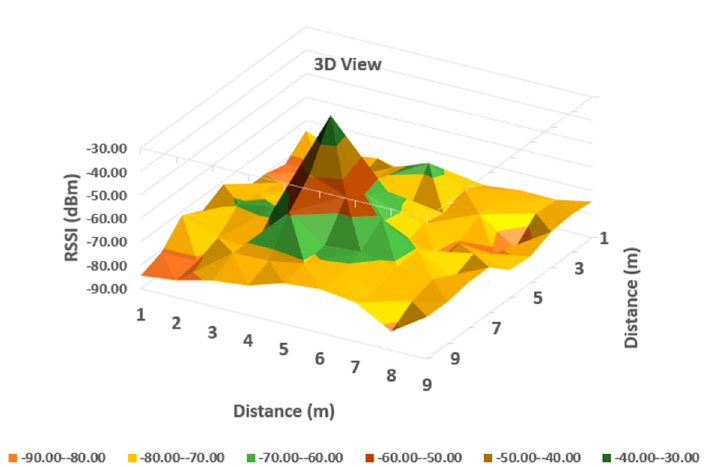
Figure 8. A two-dimensional representation of signal variation with different coloring according to RSSI measured values (Measurement point: MeS 2 ).